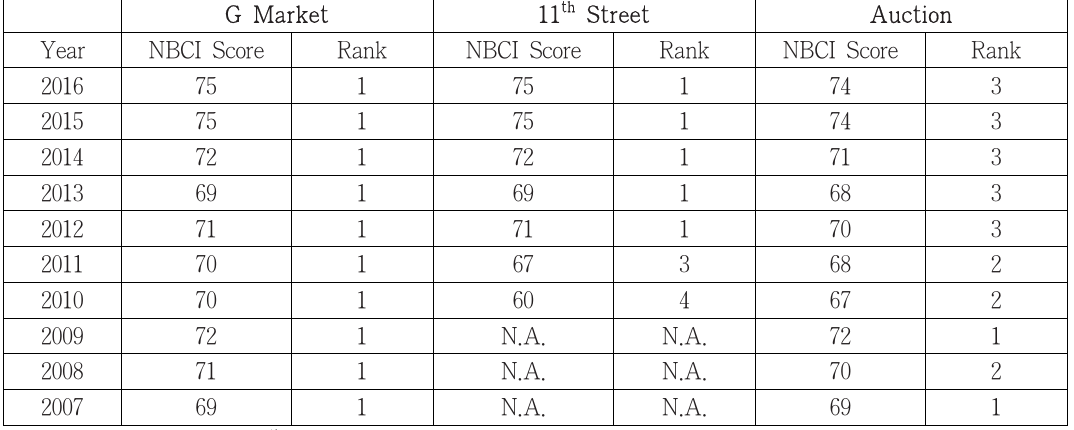
<Table 3> NBCI scores and ranks in the internet shopping market in Korea, KPC G Market